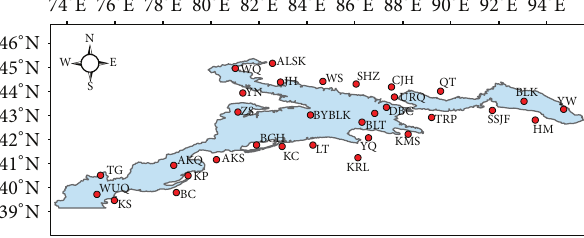
Figure 1: Location of the study area and distribution of meteorolog- ical stations.